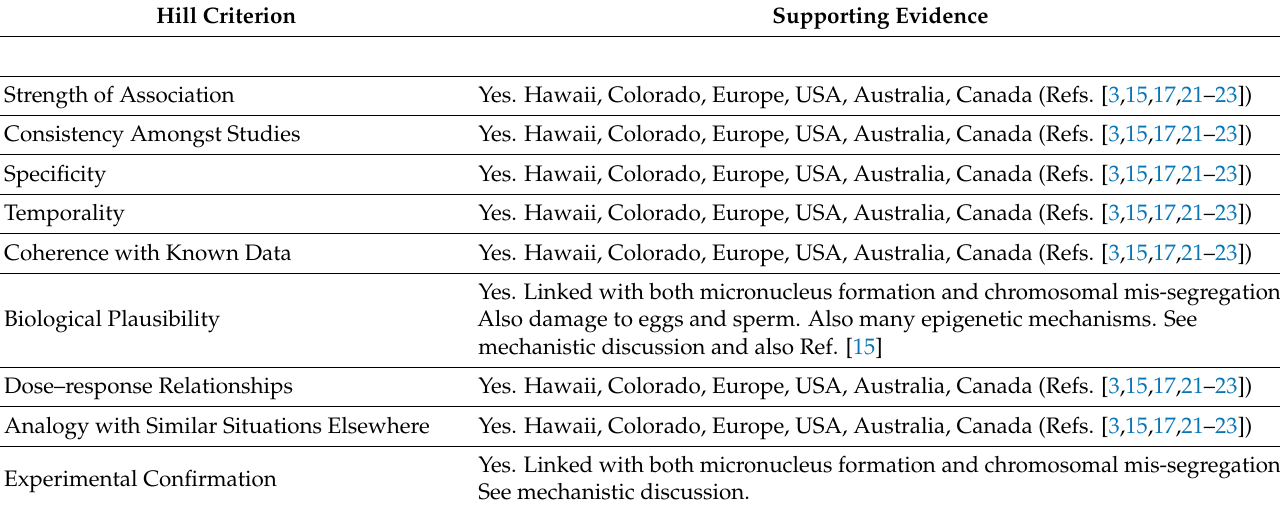
Table 8. Summary of Hill